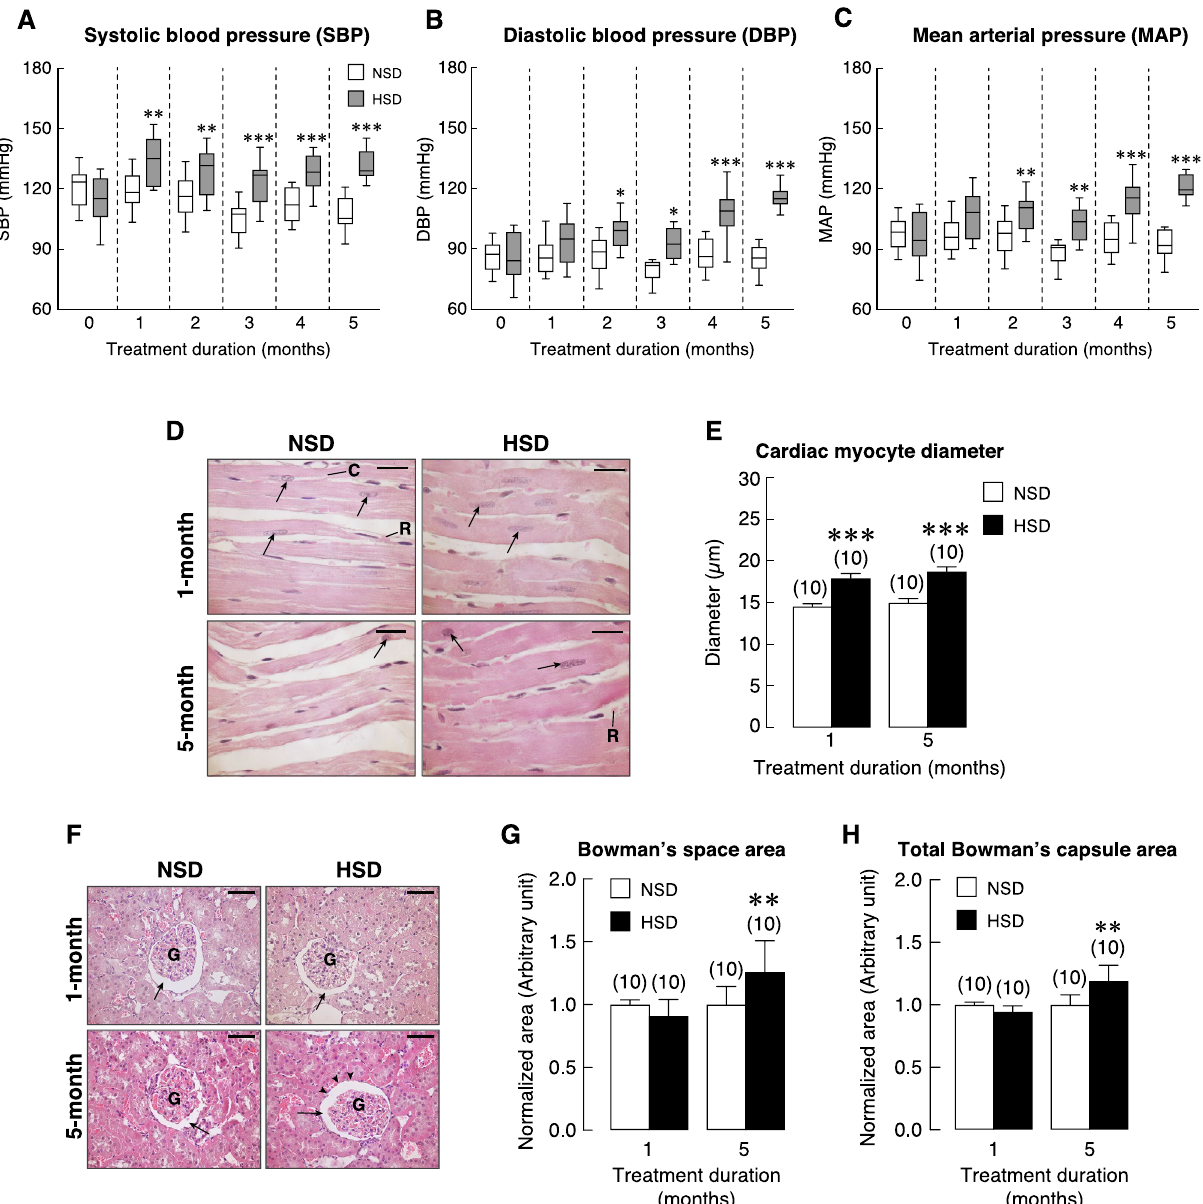
Figure 2. Blood pressure profile of NSD and HSD over 5-months of treatments. ( A ) Systolic blood pressure (SBP), ( B ) diastolic blood pressure (DBP) and ( C ) mean arterial pressure (MAP). ( D ) Representative H&E photomicrographs of cardiac myocytes obtained from rats fed with HSD or NSD for 1 month and 5 months. Arrow , nucleus of cardiac myocyte; C , vascular capillary; R , red blood cell. Scale bars, 20 μM. ( E ) Cardiac myocyte diameter of rats receiving HSD or NSD for 1 and 5 months. ( F ) Representative H&E photomicrographs of renal tissue obtained from rats fed with HSD or NSD for 1 month and 5 months. Bowman’s capsule ( arrow ) and glomerulus ( G ) were presented. Alteration of Bowman’s capsule areas was evident in HSD groups ( arrowheads ). Scale bars, 50 μm. ( G , H ) Quantitative analysis of the Bowman’s space and total Bowman’s capsule areas revealed an increase after the fifth month HSD consumption. Numbers of animals in each group are shown in parentheses. * P < 0.05, ** P < 0.01 and *** P < 0.001 compared to period-matched